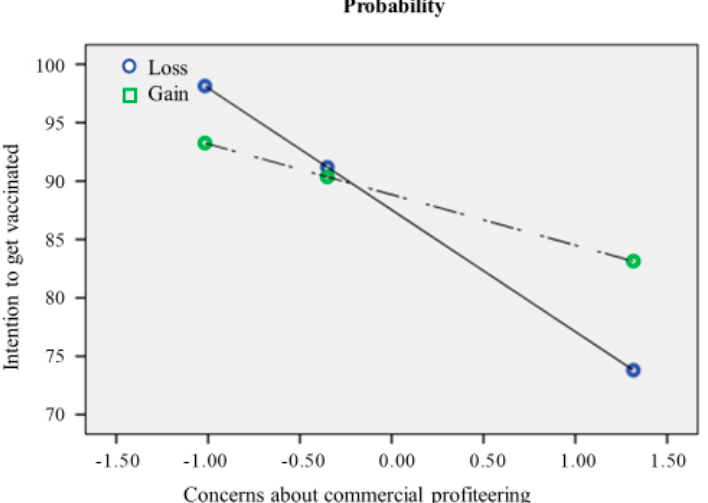
Figure 3. The relationship between concerns about commercial profiteering and intention to get the vaccine.